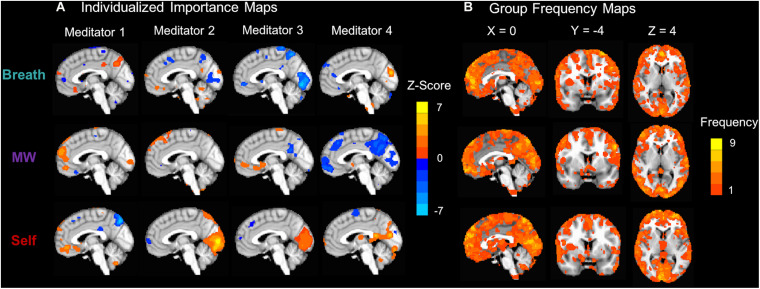
Classifier importance maps representing voxels that accurately distinguish internal mental states. (A) Subject-level importance maps showing individualized brain patterns representing voxels that are important for distinguishing neural signatures of attention to the Breath, MW, and Self (X = 0). For each task condition, importance values were computed by multiplying each voxel’s classifier weight for predicting the condition and the average activation during the condition (McDuff et al., 2009). The maps were thresholded at ± 2 SD and displayed on the MNI152 template to identify the most important voxels for each participant. Orange importance voxel indicate positive z-scored average activation values, and blue importance voxels indicate negative z-scored average activation values. (B) To examine importance voxels at the group level, group importance frequency maps indicate the number of participants for which the voxel accurately distinguished each mental state. All importance voxels were summed, irrespective of average positive or negative z-scored activation. Frequency maps were also computed that independently summed positive (Supplementary Figure S2A) and negative (Supplementary Figure S2B) z-scored activation voxels, as well as histograms of frequency counts (Supplementary Figures S2c–e). Note that the maximum frequency for any importance map was 9/15.